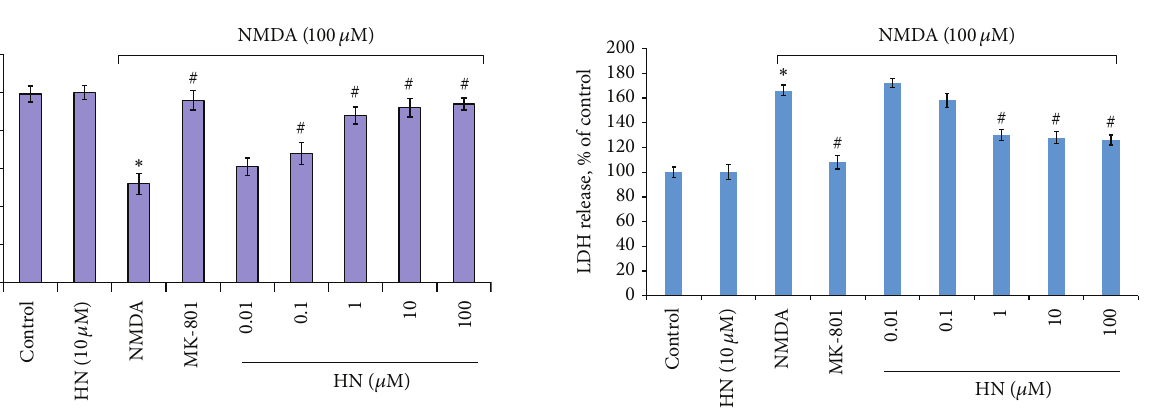
Figure 4: Effect of humanin on NMDA triggered LDH release in cultured cortical neurons. Each bar represents mean ± SEM of 5– 8 independent observations. Statistical significance is at 𝑃 < 0.05 . = 3.023 and 𝑃 = 0.006 after one-way ANOVA analysis 𝐹 (8,64) in SPSS. ∗ represents control versus NMDA group ( 𝑃 = 0.028 ); # represents NMDA group versus NMDA + MK-801 group ( 𝑃 = 0.019 ) or NMDA + HN (Humanin) group. HN (0.01 𝜇 mol/L), 𝑃 = 0.384 ; HN (0.1 𝜇 mol/L), 𝑃 = 0.301 ; HN (1 𝜇 mol/L), 𝑃 = 0.039 ; HN (10 𝜇 mol/L), 𝑃 = 0.036 ; HN (100 𝜇 mol/L), 𝑃 = 0.040 . ∗ and # mean that there is statistical significance between control and treatment